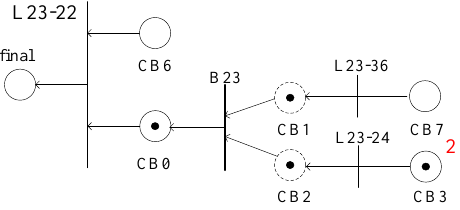
Figure 7. The backward reasoning Petri net of